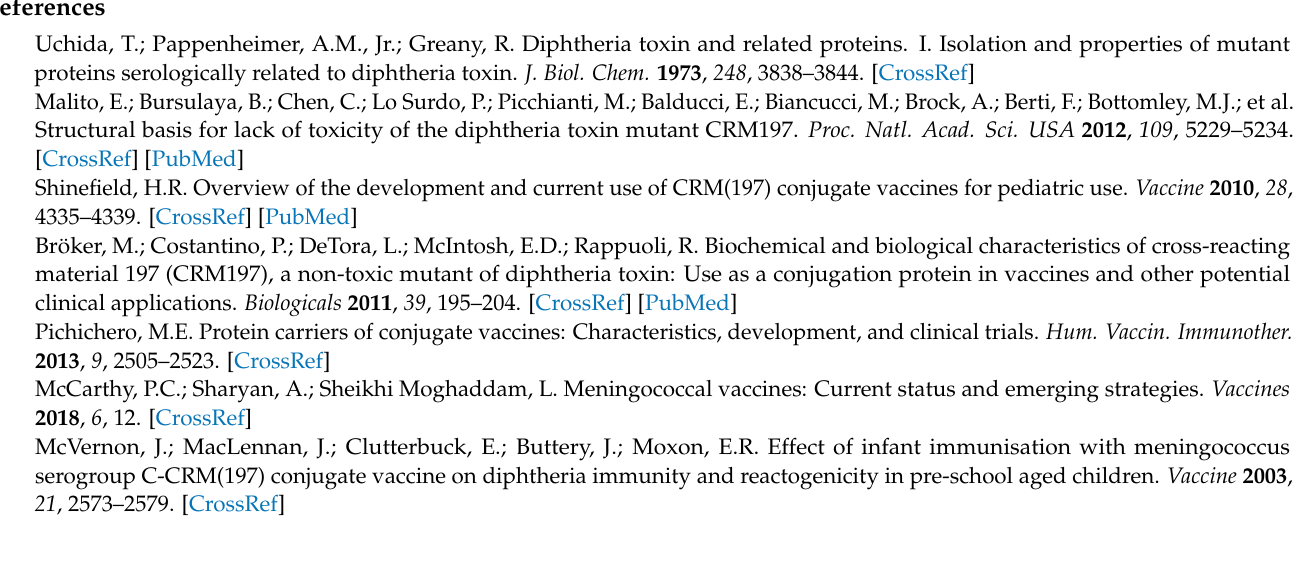
Table S1: The primers used to obtain the CRM197 insertion and deletion mutants; Table S2: The primers used to make the point mutations in the CRM197-encoding gene; Table S3: Characteristics of the full-length mRNA (1825 bases) calculated using the RNAfold algorithm; Table S4: Characteristics of the 140-base fragment that includes the mutated codon calculated using the RNAfold algorithm; Table S5: Characteristics of the 33-base fragment that includes the mutated codon calculated using the RNAfold